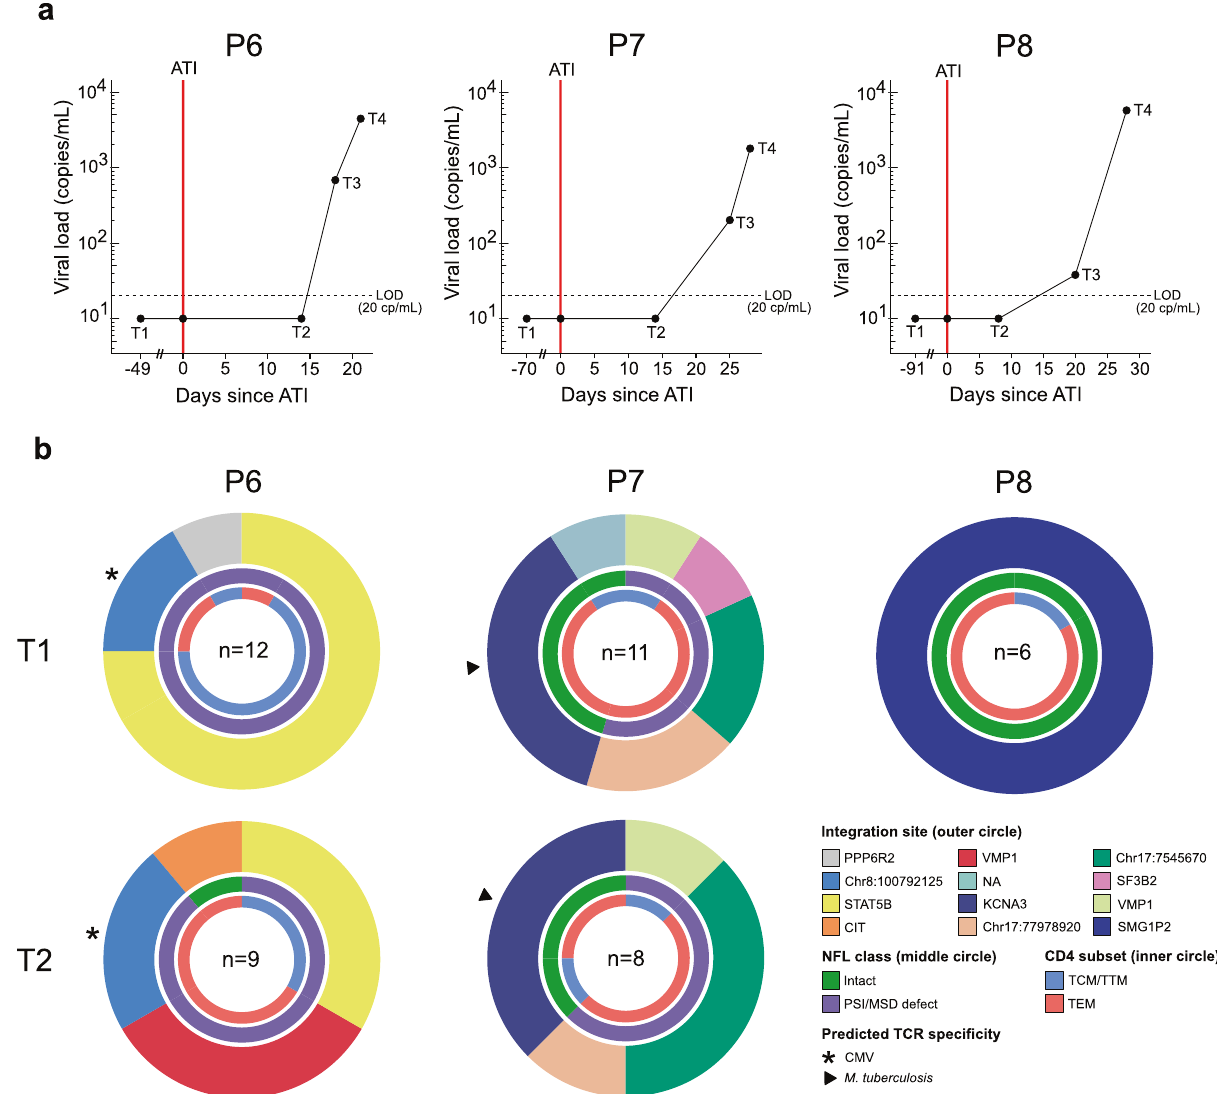
Fig. 4 STIP-Seq on three participants before and during an analytical treatment interruption (ATI). a Viral load diagram showing the sampling time points before (T1) and during (T2, T3, T4) the analytical treatment interruption for three participants (P6, P7, P8). The viral load was undetectable at T1 and T2, under 1000 cp/mL at T3 (early rebound) and above 1000 cp/mL at T4 (late rebound). The vertical red line depicts the start of the ATI. LOD limit of detection. b Donut charts displaying integration sites, NFL class, and memory subsets of p24-producing cells recovered before (T1) and during (T2) an ATI. The number of analyzed p24 + cells is indicated for each participant. PSI packaging signal, MSD major splice donor, TCM central memory T cell, TTM transitional memory T cell, TEM effector memory T cell, NFL near full